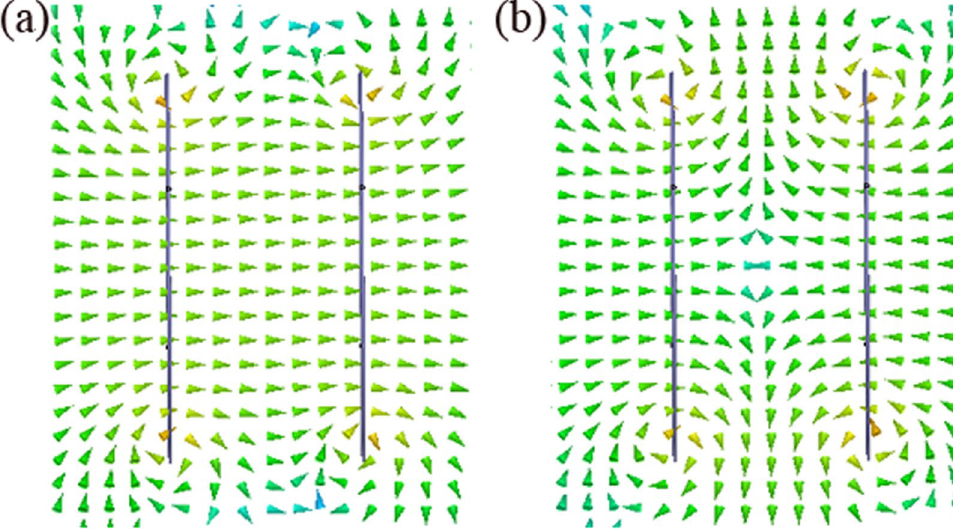
Figure 3. Incident and reflected magnetic field vector distributions in xy plane. ( a ) Distribution corresponding to Fig. 2(a). ( b ) Distribution corresponding to Fig.